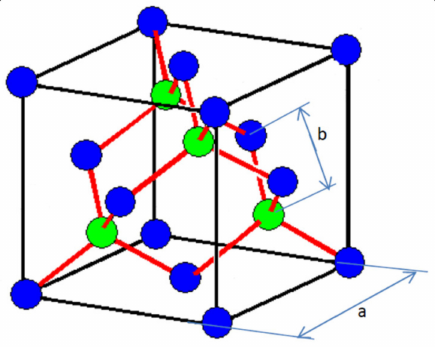
Figure 2. The face centered cubic lattice structure of